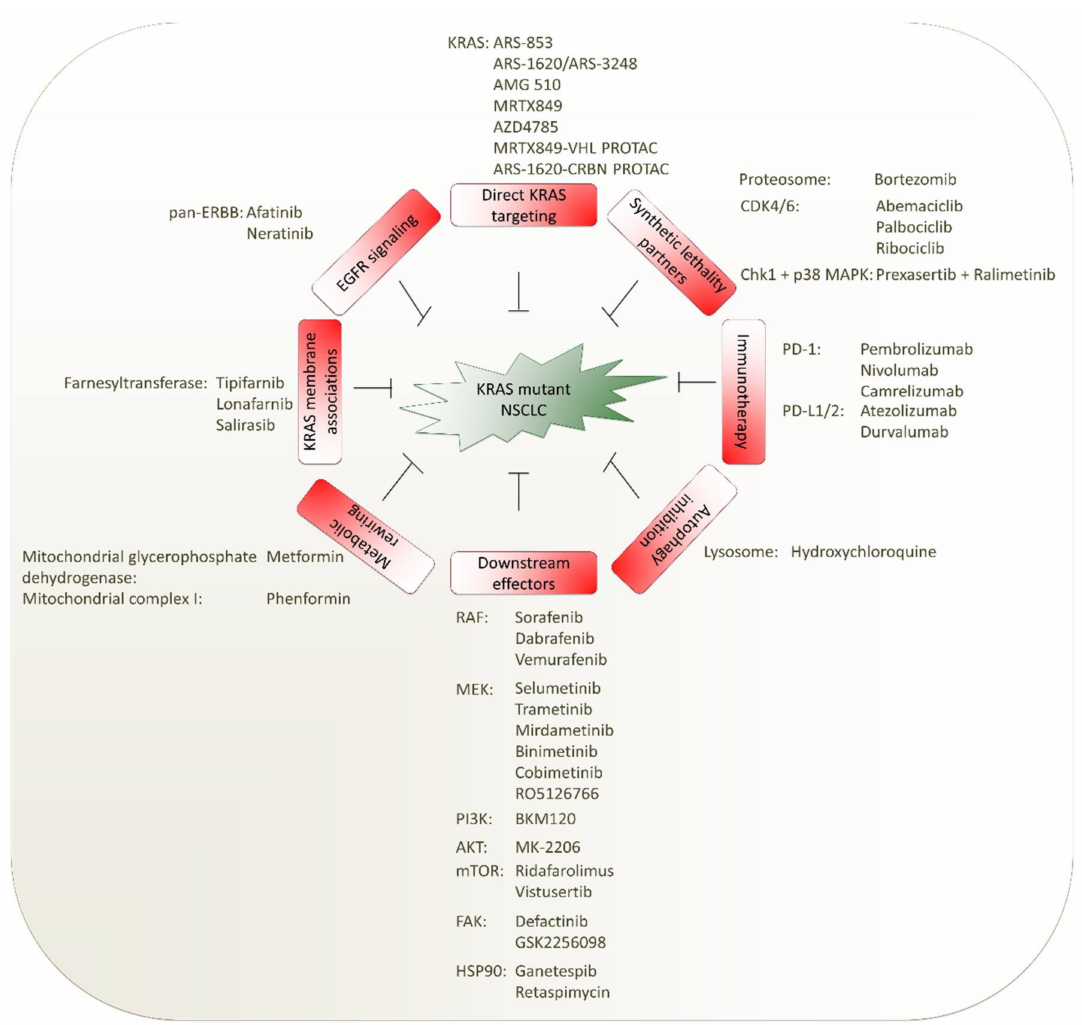
Figure 3. Therapeutic approaches to tackle KRAS mutant NSCLC in patients. Selected compounds and their targets are listed. CDK4 / 6: cyclin-dependent kinase 4 / 6; Chk1: checkpoint kinase 1; CRBN: cereblon; PROTAC: proteolysis-targeting chimeras; VHL: von Hippel–Lindau disease tumor suppressor; HSP90: heat shock protein 90; RAF: rat fibrosarcoma; MEK: mitogen-activated protein kinase kinase; PI3K: phosphoinositide 3-kinase; AKT: protein kinase B; mTOR: mechanistic target of rapamycin kinase; KRAS: Kirsten rat sarcoma viral oncogene homolog; FAK: focal adhesion kinase; ERBB: human epidermal growth factor receptor; PD-1: programmed cell death protein 1; PD-L: programmed cell death 1 ligand; MAPK: mitogen-activated protein